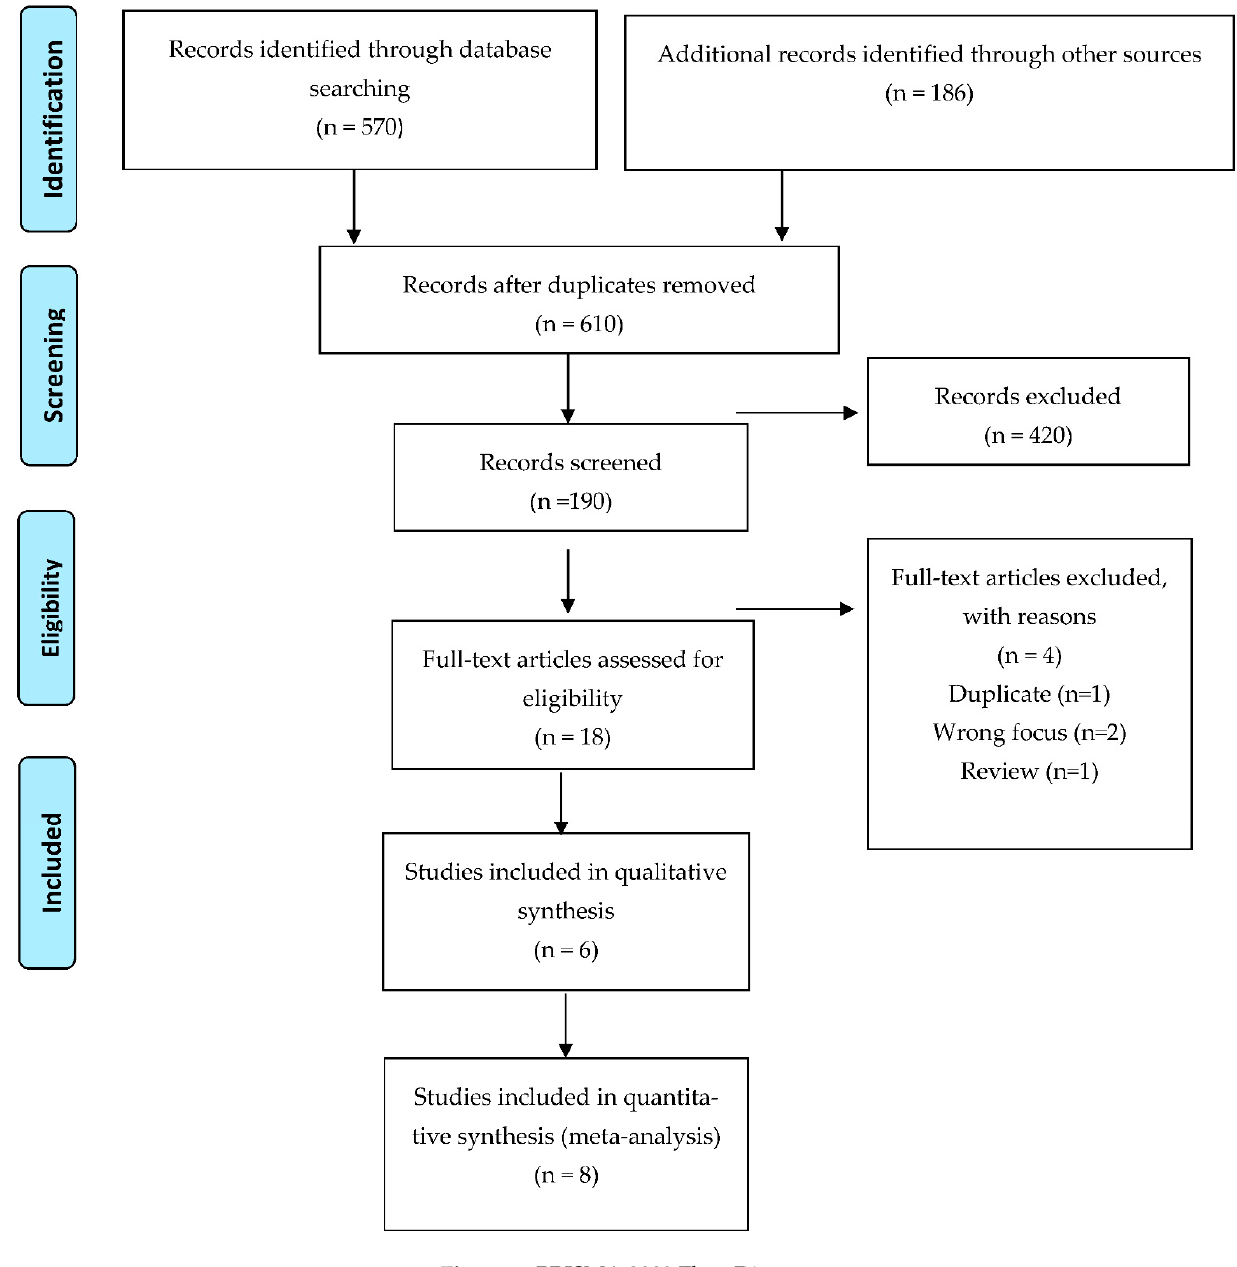
Figure 1. PRISMA 2009 Flow Diagram.